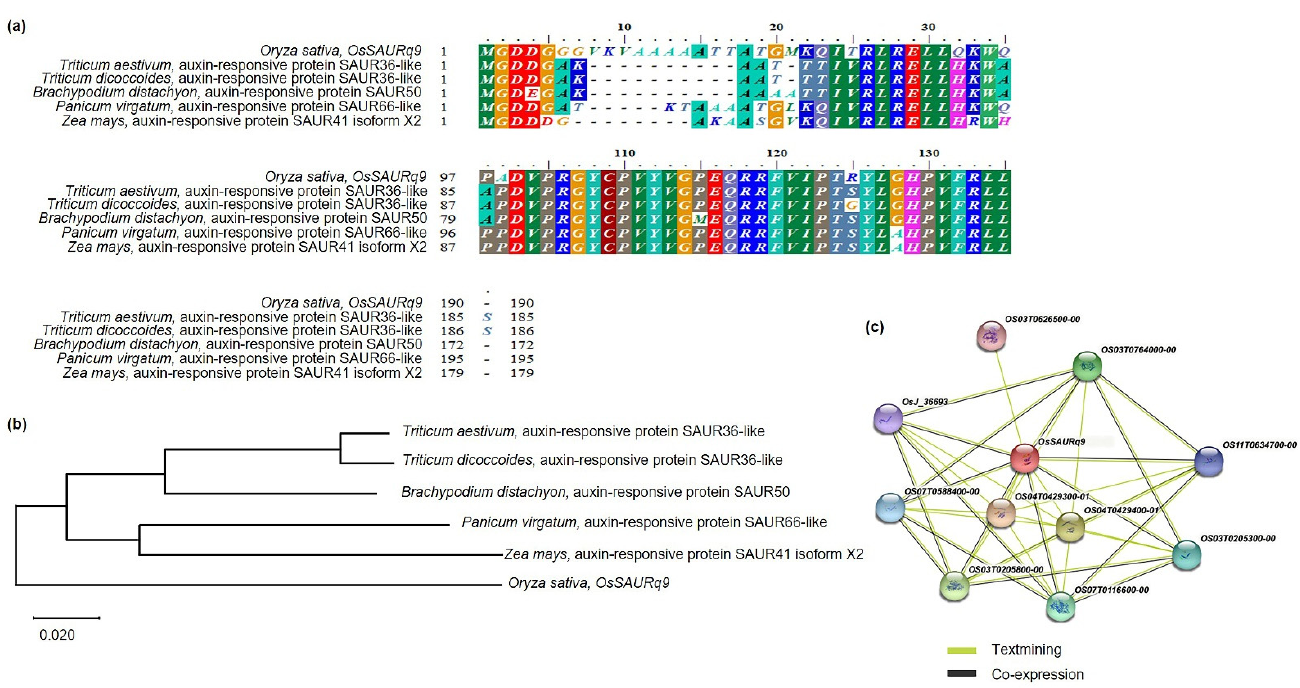
Figure 7. Sequence analysis of OsSAURq9 . ( a ) The high similarity protein sequences with OsSAURq9 were found in Triticum aestivum , Triticum dicoccoides , Brachypodium distachyon , Panicum virgatum , and Zea mays . ( b ) The gene and homologous gene were analyzed using a phylogenetic tree using 1000 bootstrap replicates to build the phylogenetic tree through the parsimony method. ( c ) Protein interactions of OsSAURq9 . OsSAURq9 interacts with ten different proteins (OS04T0429300-01, OS04T0429400-01, OS03T0205800-00, OS03T0764000-00, OS07T0116600-00, OS03T0205300-00, OS07T0588400-00, OS11T0634700-00, OsJ_36693, and OS03T0626500-00).